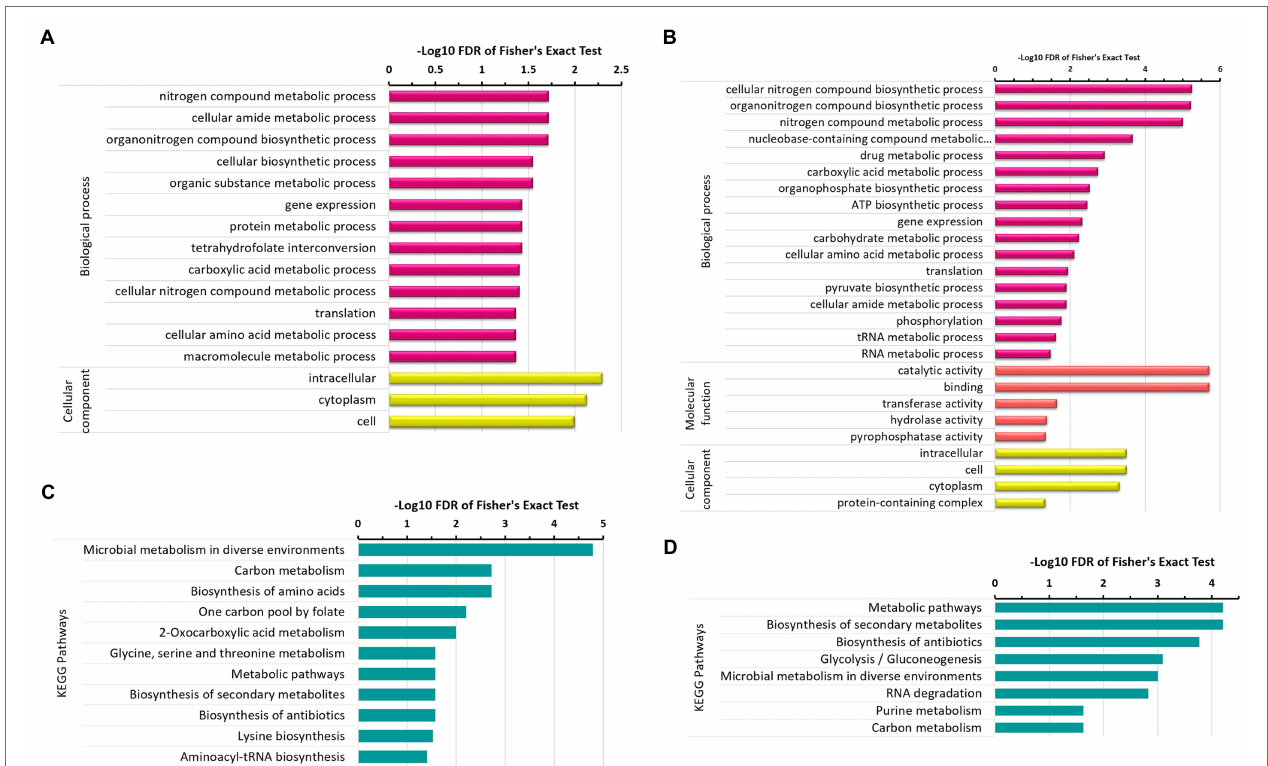
FIGURE 5 | Enrichment analysis of differentially acetylated proteins in Z. mobilis under N 2 -fixing and non-fixing conditions. (A) GO terms enrichment analysis of uniquely acetylated proteins of N 2 -fixing condition. (B) GO terms enrichment analysis of uniquely acetylated proteins of non-fixing condition. (C) KEGG pathways enrichment analysis of uniquely acetylated proteins of N 2 -fixing condition. (D) KEGG pathways enrichment analysis of uniquely acetylated proteins of non-fixing